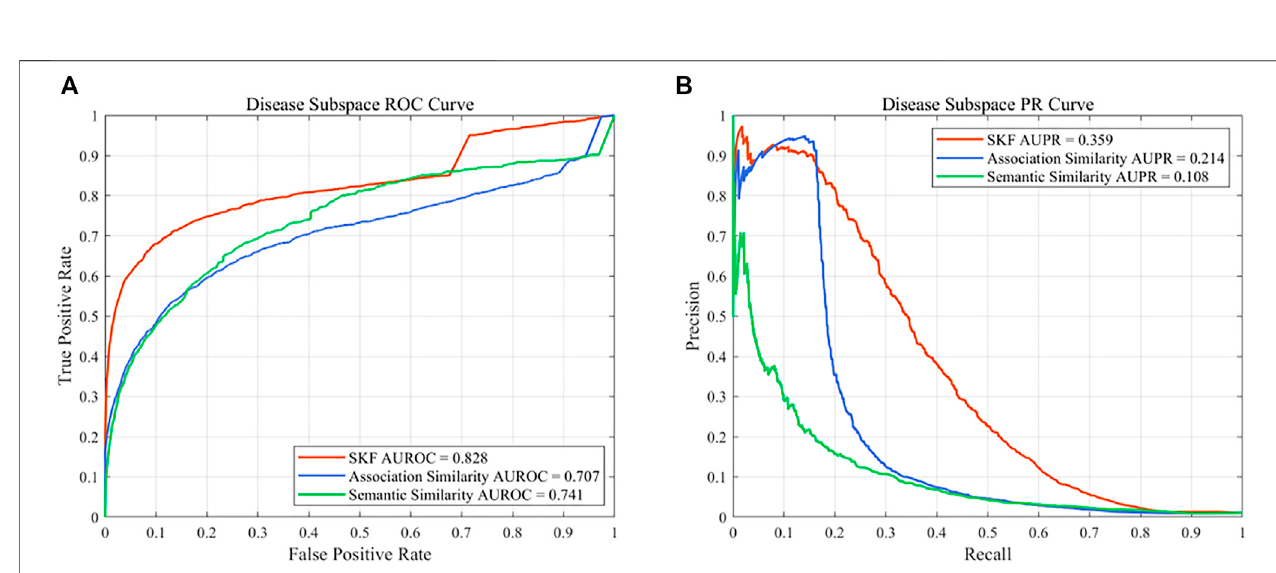
FIGURE 3 | Performance of the single similarity and SKF in the disease subspace of the PREDICT dataset. (A) ROC curve and (B) PR curve.